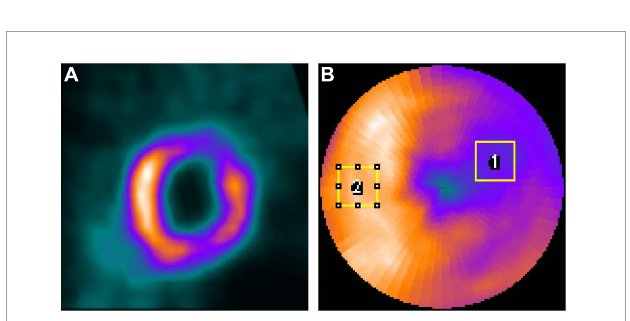
FIGURE3 (A) The 3D VOI used for voxel-based error calculation. (B) Sample ROIs drawn from a polar plot for IR calculation on a selected patient. (ROI 1 was for defect while ROI 2 was for a uniform normal region).